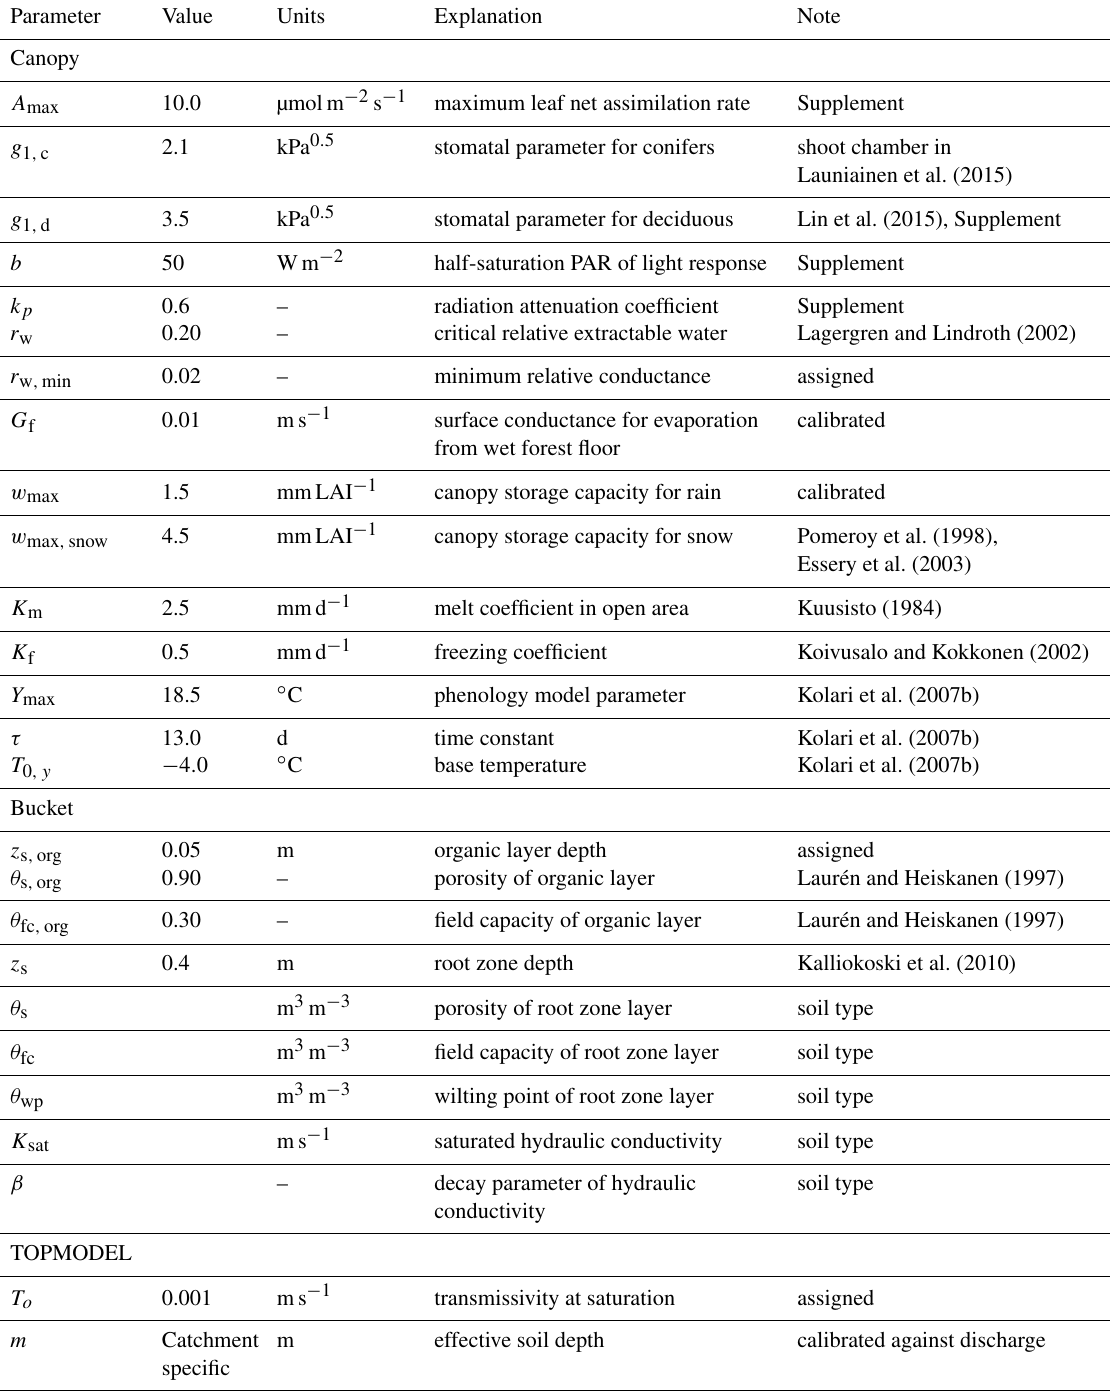
Table 1. Generic parameter set used in stand- and catchment-scale simulations.